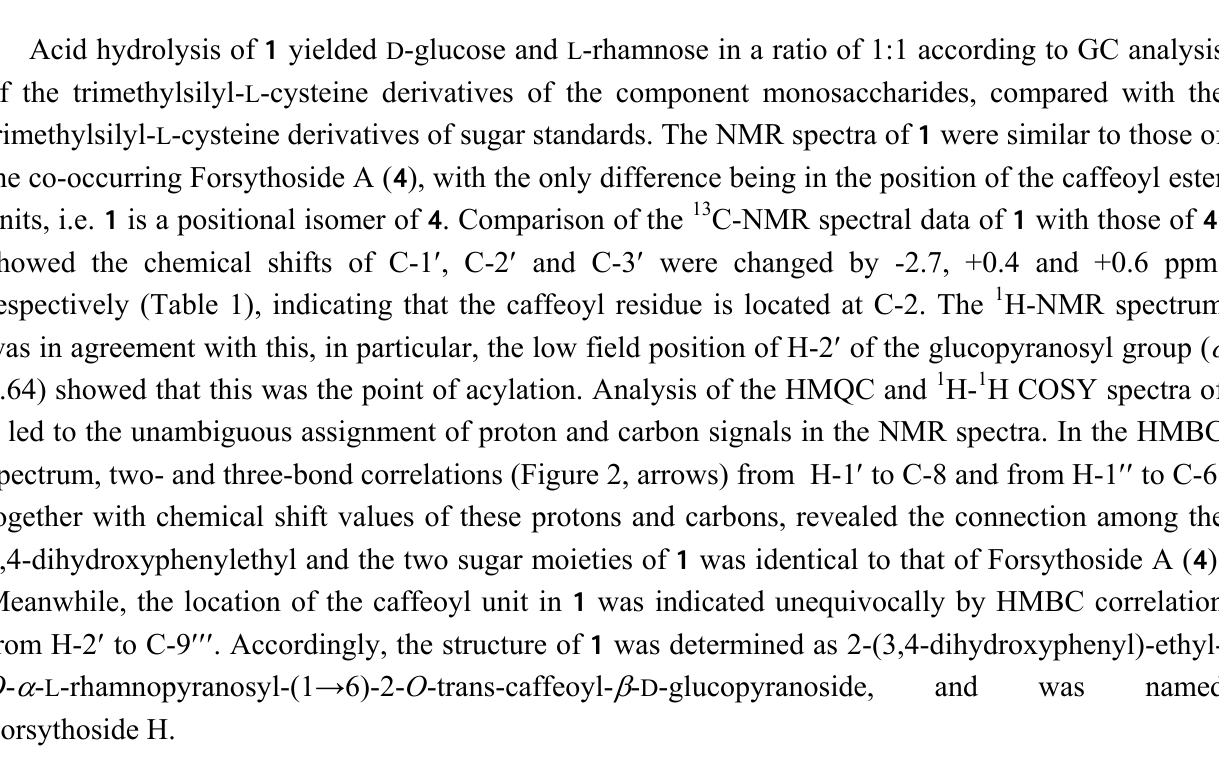
Figure 2. Main 1 H- 1 H COSY (thick lines) and HMBC (arrows from proton to carbon) correlations of Forsythoside H ( 1